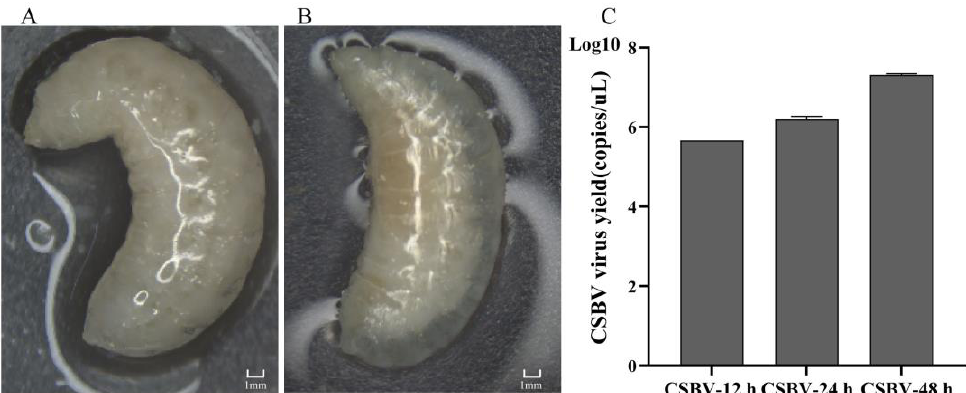
Figure 1. Morphological characteristics of CSBV-infected larvae and relative quantification analysis of CSBV at each time point after larvae infection. The CSBV-infected larva ( B ) was swollen and smaller compared with the healthy larvae of A. c. cerana ( A ). ( C ) The copies of the CSBV virus.